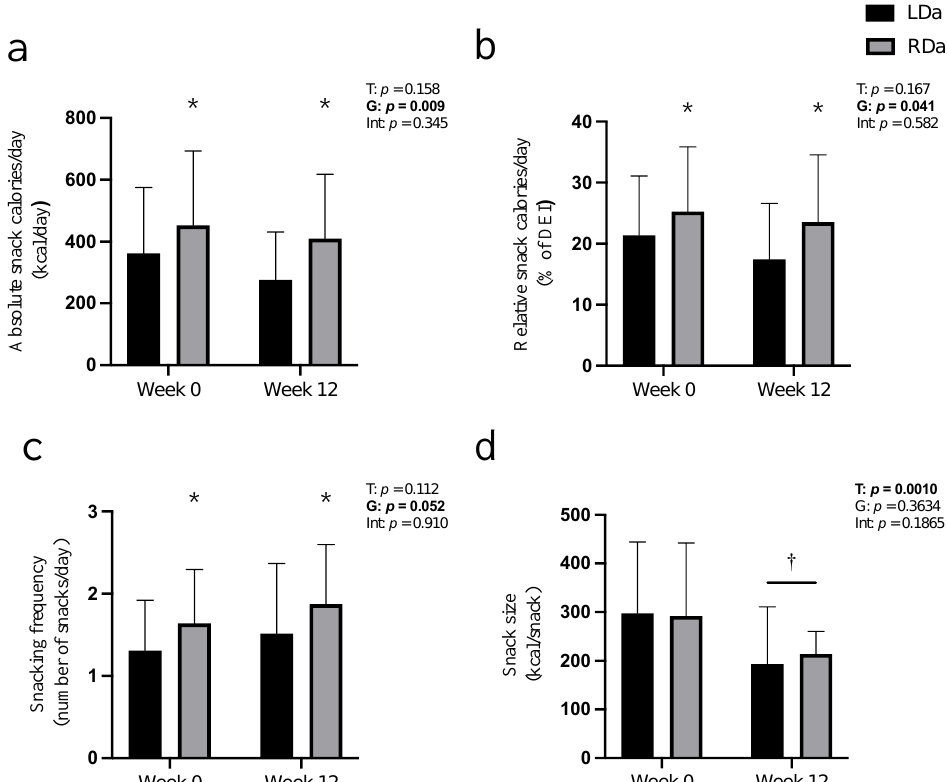
Figure 1. Snacking characteristics in the adolescent females with overweight/obesity in the and low dairy product intake (LDa) and recommended dairy product intake (RDa) groups before (week 0) and following the 12-week lifestyle modification intervention. Absolute snack energy intake (kcal per day) ( a ); relative snack energy intake (% of daily energy intake (DEI)) ( b ); snacking frequency (number of snacks per day) ( c ); and snack size (kcal per snack ( d )) are displayed separately. Group (G), time (T), and interaction (Int) p -values are presented from the repeated-measures ANOVAs ( p ≤ 0.05 presented in bold). Symbols denote a significant main effect of group (* p ≤ 0.05) and a significant main effect of time († p ≤ 0.05). Data are presented as mean ± standard deviation (LDa = 21, RDa n = 22). Absolute snack energy and snack size analyses were run with log-transformed data sets.